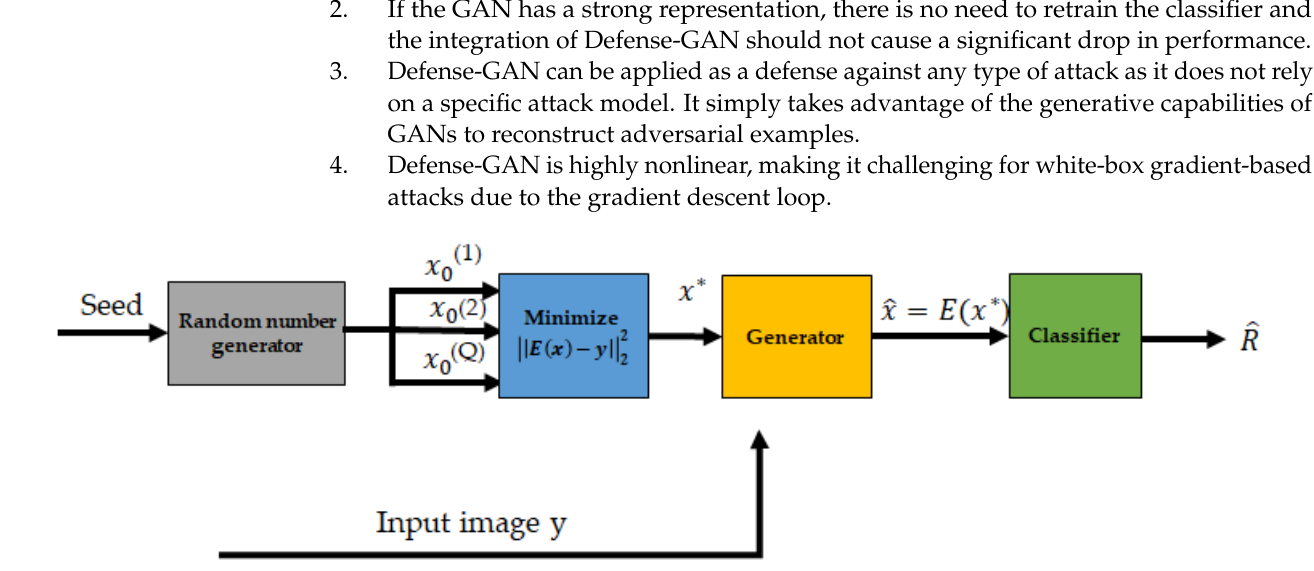
Figure 24. Overview of the Defense-GAN [146]. If the GAN is properly trained and has a strong representation of the data, the original clean image and its reconstruction should be similar.